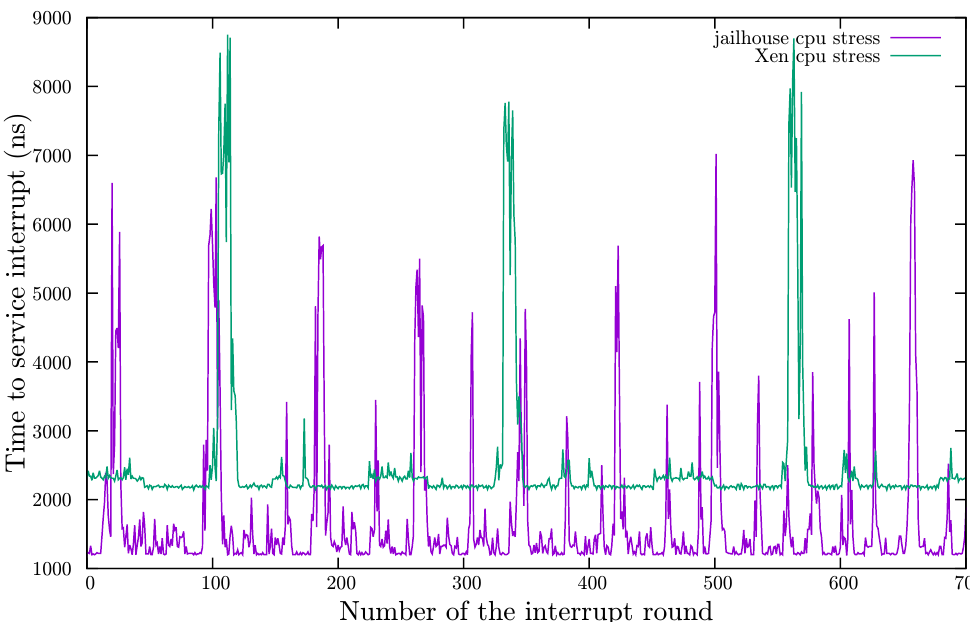
Figure 4. Results for Xen and Jailhouse when CPU is stressed. Overall, Jailhouse has a better baseline, although many more spikes than Xen. These spikes correspond to transients in the hypervisor.